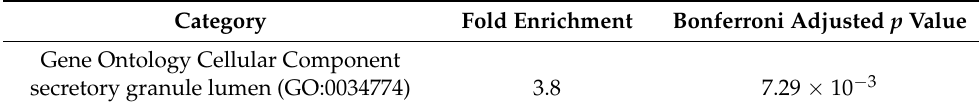
Table A3. Based on 58 DMRs for Discordant Curve Severity, one Significantly Enriched Ontology was Identified. Analysis of Discordant Curve Severity in Twin Pairs Identified n = 57 Differen- tially Methylated Regions where Hyper- or Hypomethylation was Consistent Across all Probes in the Region.